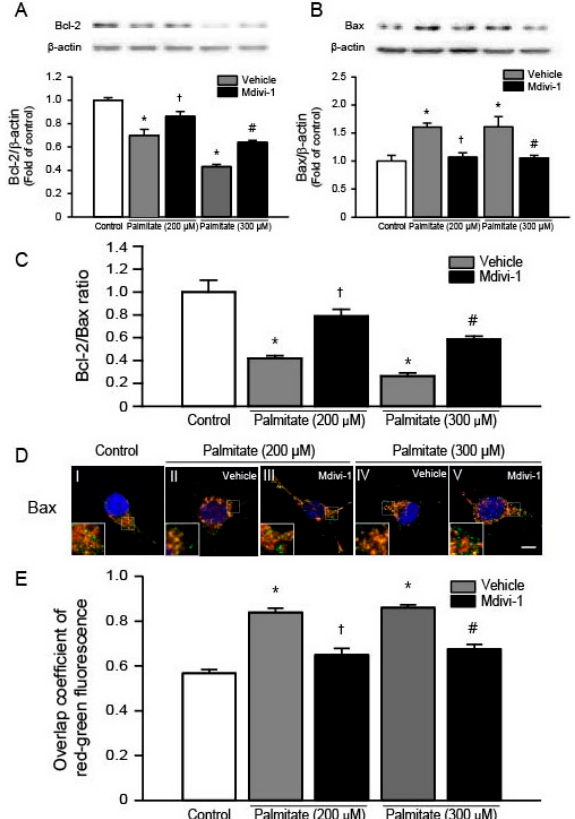
Figure 5. Effect of mdivi-1 on Bcl-2 and Bax levels in hippocampal NSCs exposed to palmitate insult. Cells were pretreated with DMSO vehicle or mdivi-1 (20 µ M) for 2 h and then exposed to 0.5% BSA vehicle or palmitate (200 and 300 µ M) for 24 h. Bcl-2 ( A ); and Bax ( B ) protein levels were assessed by Western blot. Bcl-2 and Bax band intensities were normalized to β -actin intensity; ( C ) Bar graphs show the ratio of protein levels of Bcl-2 to Bax; ( D , E ) Effect of mdivi-1 on Bax translocation from the cytosol to the mitochondria. At the completion of palmitate exposure, cells were stained with MitoTracker ® Orange CMTMRos (red) and then probed with Bax antibody (green) to detect subcellular localization of Bax. Nuclei were visualized by staining with DAPI. Representative microscopic images show immunofluorescent detection of Bax ( D ). Scale bar, 5 µ m. Quantitative analysis for overlap coefficient of red-green fluorescence ( E ). Values are the mean ± SEM of four separate experiments performed in triplicate. * p < 0.05 vs. DMSO-treated control; † p < 0.05 vs. 200 µ M palmitate; # p < 0.05 vs. 300 µ M